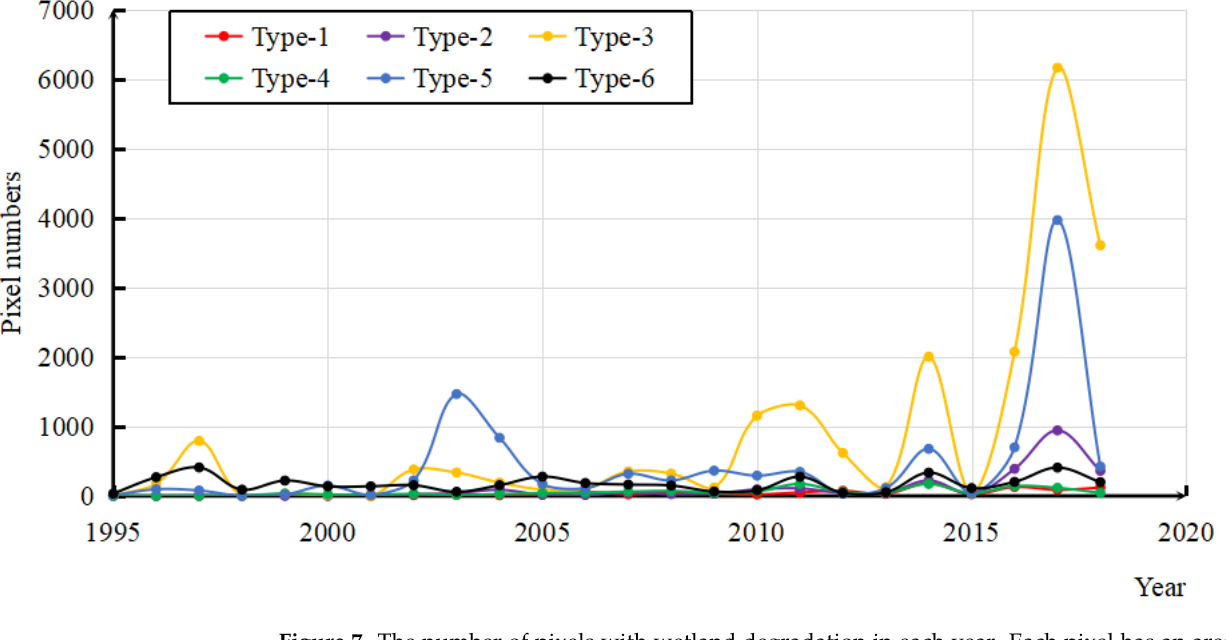
Figure 7. The number of pixels with wetland degradation in each year. Each pixel has an area of 30 m × 30 m.